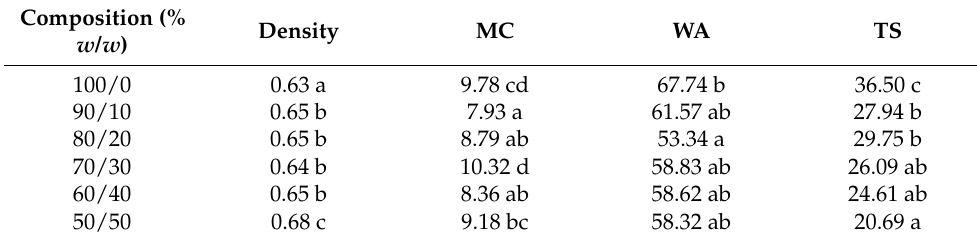
Table 4. Duncan multi-range-test of physical properties.